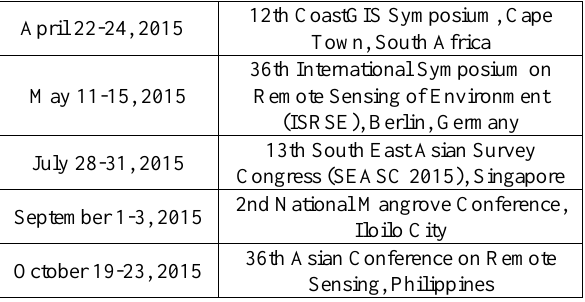
Table 3. Conferences attended by the UPD CoastMap